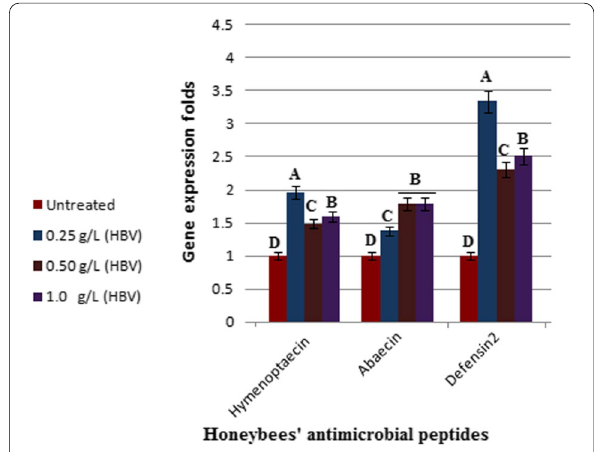
Fig. 5 The effect of honeybee venom (HBV) in different concentrations on the expression folds of antimicrobial peptides for honeybee with SE performed in ±